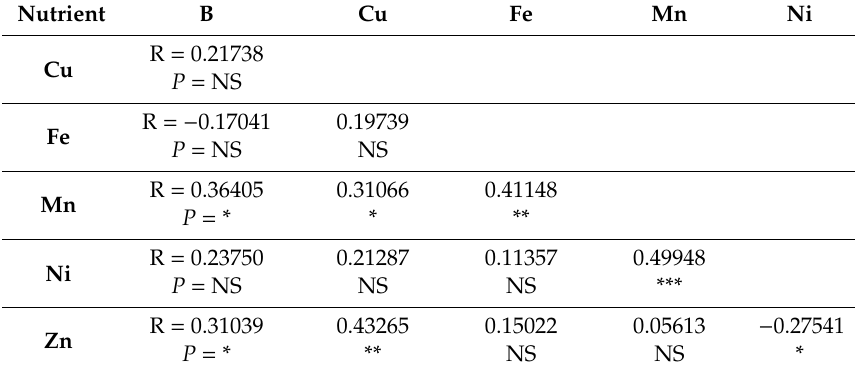
Table 5. Pearson correlation coe ffi cients ( P and R values) between cottonseed minerals in CS lines grown in MS 2014.